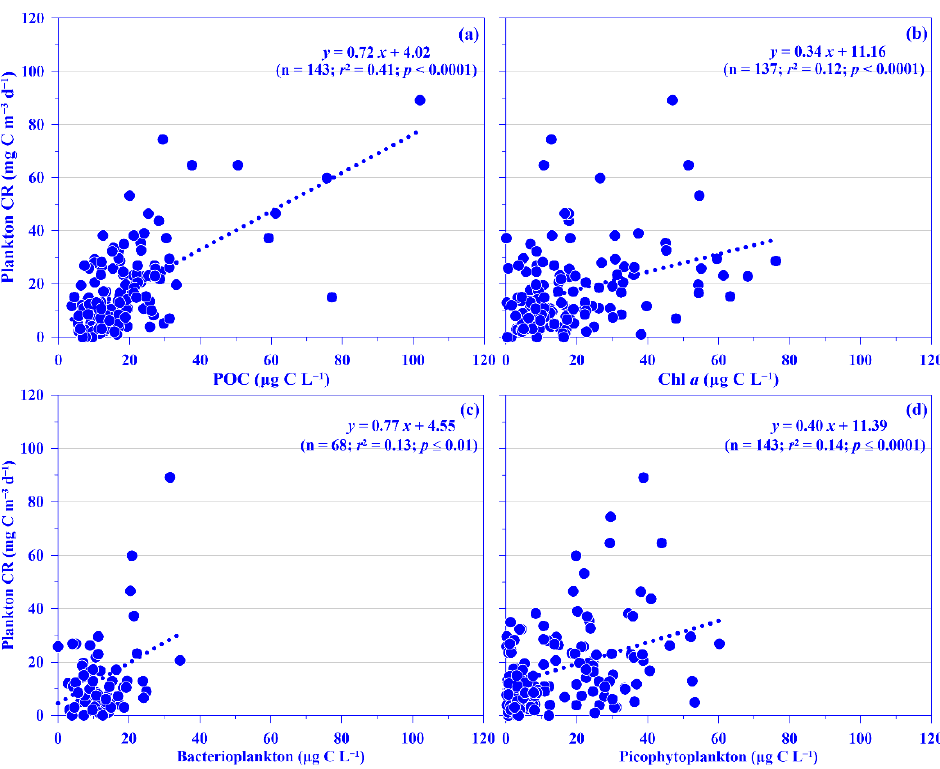
KTV1 transect of the Kuroshio. The depth-normalized integrated value over 100 m water column of each variable at each sampling station was used for the mean values. The mean values were averaged across all stations of the KTV1 transect for each sampling period or across each station of the KTV1 transect for all sampling periods. The standard deviations are illustrated as vertical white lines with caps.